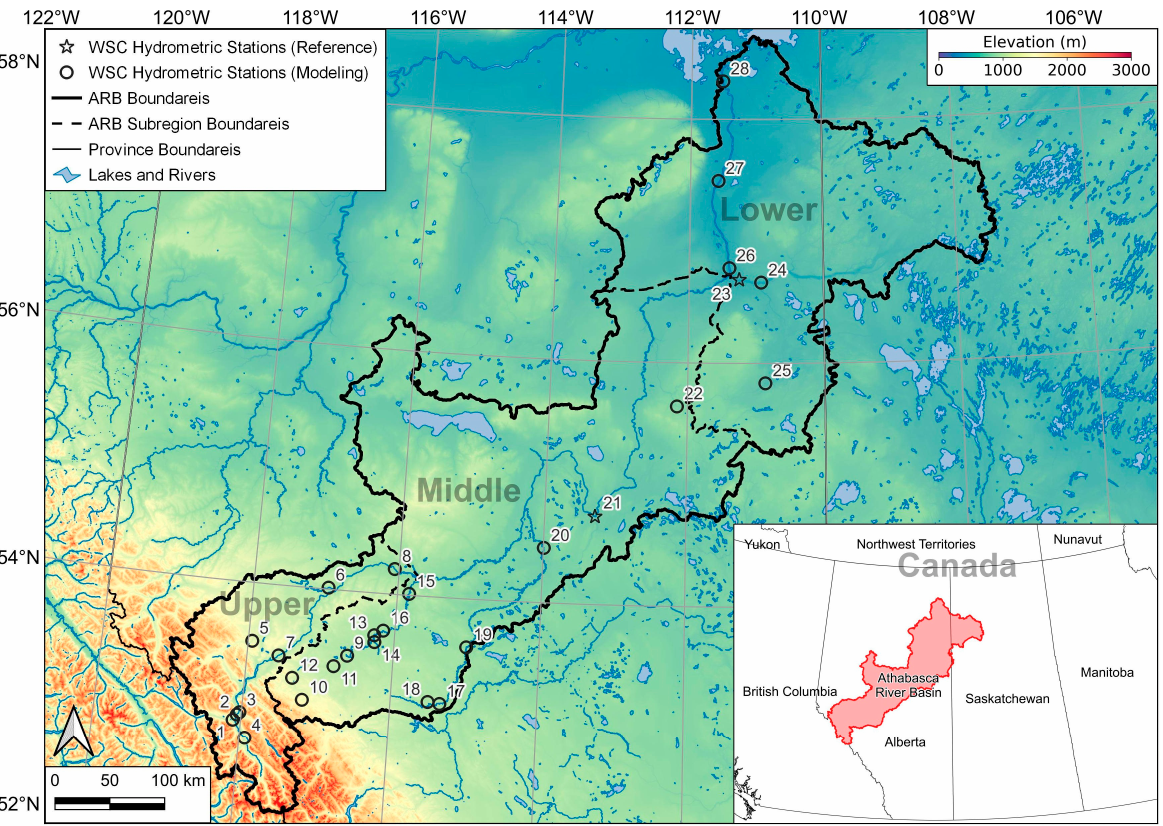
Figure 1. A map of the Athabasca River Basin (ARB) is presented, showing the topography of the area through a gradient background color generated using shuttle radar topography mission (SRTM) data sampled at 30 m. The location of the ARB within Canada is illustrated in the right-corner window. The hydrometric stations designated for the reconstruction of streamflow data through modeling are indicated by circles, and the stations selected for reference in the modeling process are represented by stars. The numbers appearing on the map correspond to the custom IDs we have allocated to the hydrometric stations. Table 1 contains a detailed inventory of the hydrometric stations we have assigned IDs to, along with their corresponding names. Table 1. A list of hydrometric stations utilized in this study. Stations with continuous monthly stream fl ow data from 1960 to 2022 are highlighted in gray to indicate their completeness. The IDs we have assigned to each hydrometric station in the maps used in this article are indicated by the symbol #.